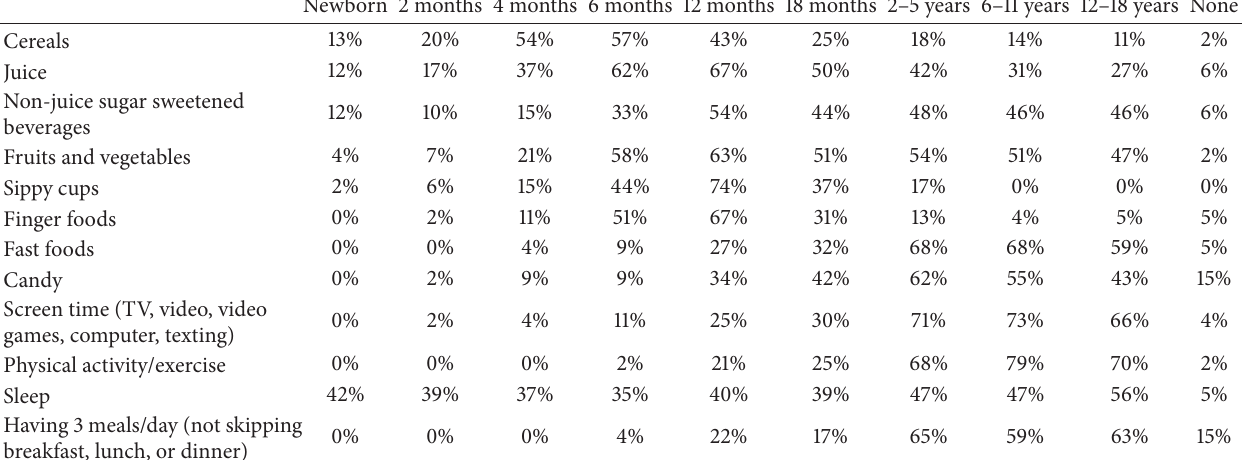
Table 2: Distribution of well-child checks at which respondents address obesity-related topics during childhood and adolescence expressed as the percentage providing affirmative responses to the question “At which well-child check(s) do you typically talk about the following? Mark all that